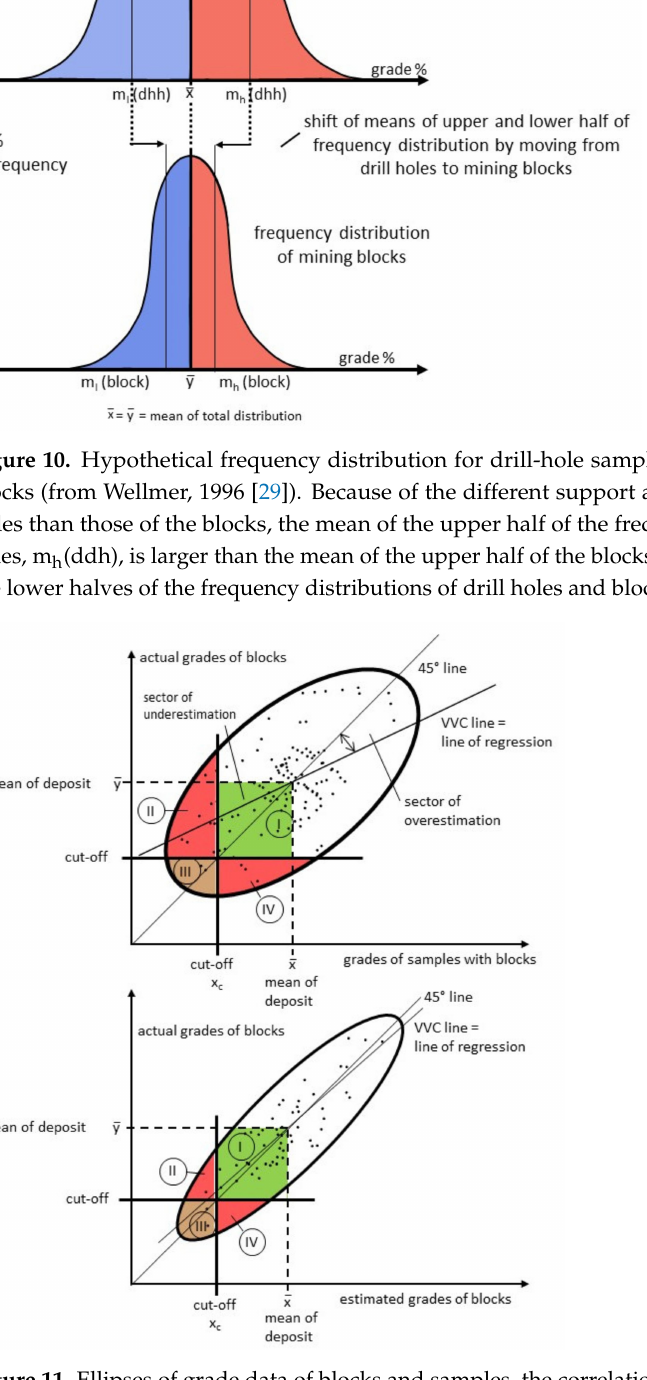
Figure 11. Ellipses of grade data of blocks and samples, the correlation between them, and the effect of the application of a cutoff grade x c . Top: normal case, bottom: narrowed ellipse with the help of better grade-control